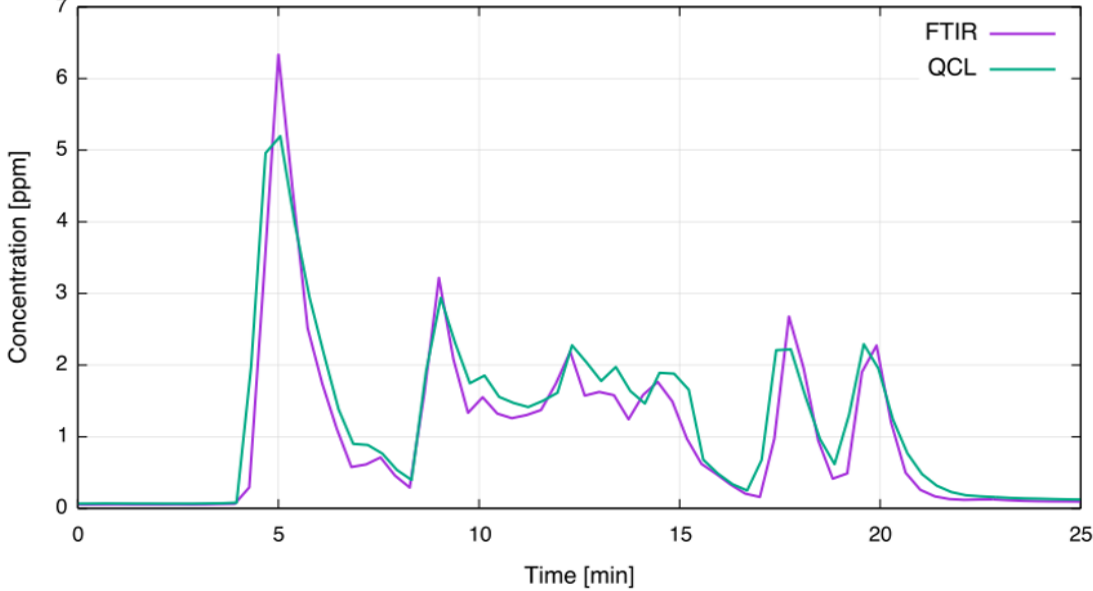
Figure 7. Comparison of extractive FTIR and in-situ QCL concentration measurements during multiple anode